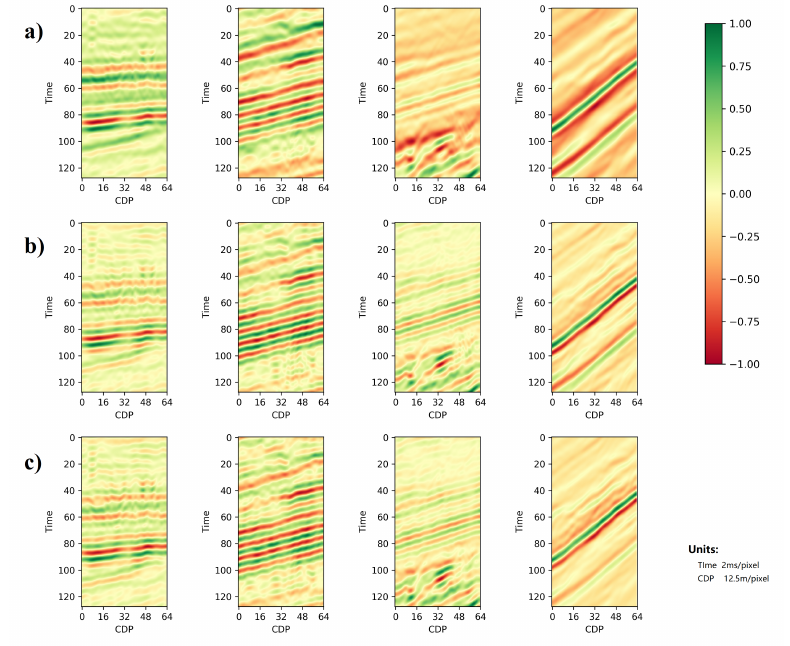
Figure 11. True QPSTM patches and patches for unseen data, predicted using the network. Patches in panel ( a ) represent the input of the network. The predicted patches (shown in panel ( b )) are almost the same as the true patches (panel ( c )), which indicates that the network has a high generalization ability.